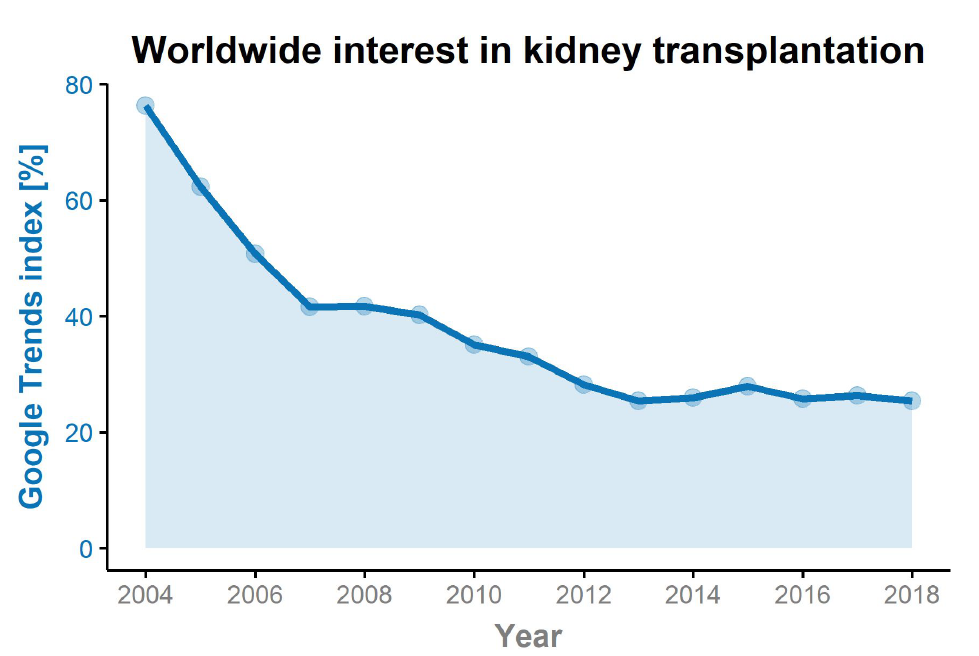
Figure 1. A worldwide decrease in the Google Trends TM indices from inception to 2018 was